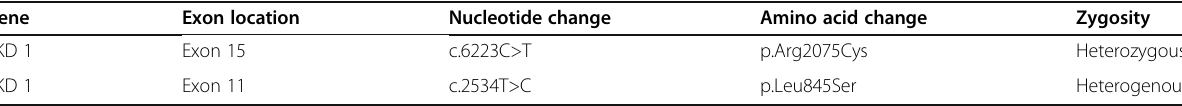
Table 1 The summary of the novel mutations in PKD1 gene in this patient with congenital hepatic fibrosis